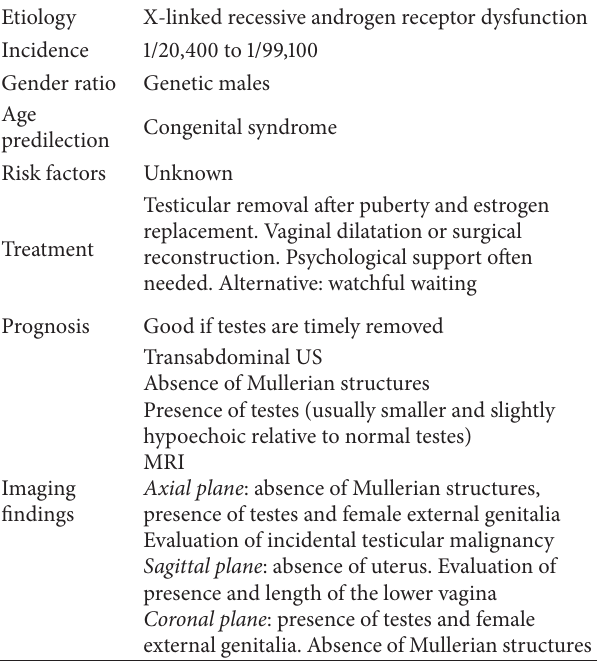
Table 1: Summary table for complete androgen insensitivity syn- drome